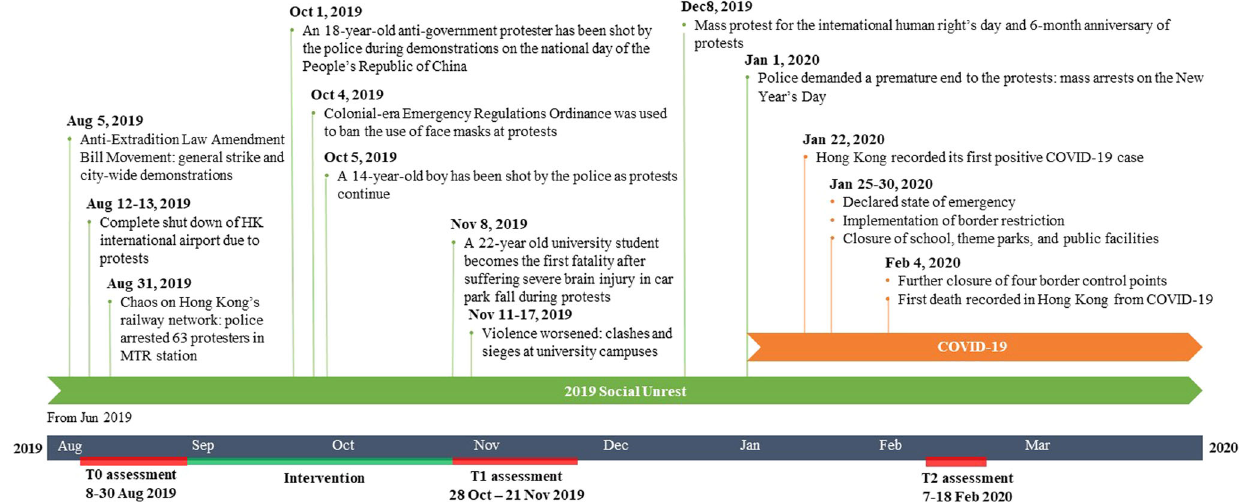
Fig. 2 Major events in Hong Kong during the study implementation from Aug, 2019 to Feb,